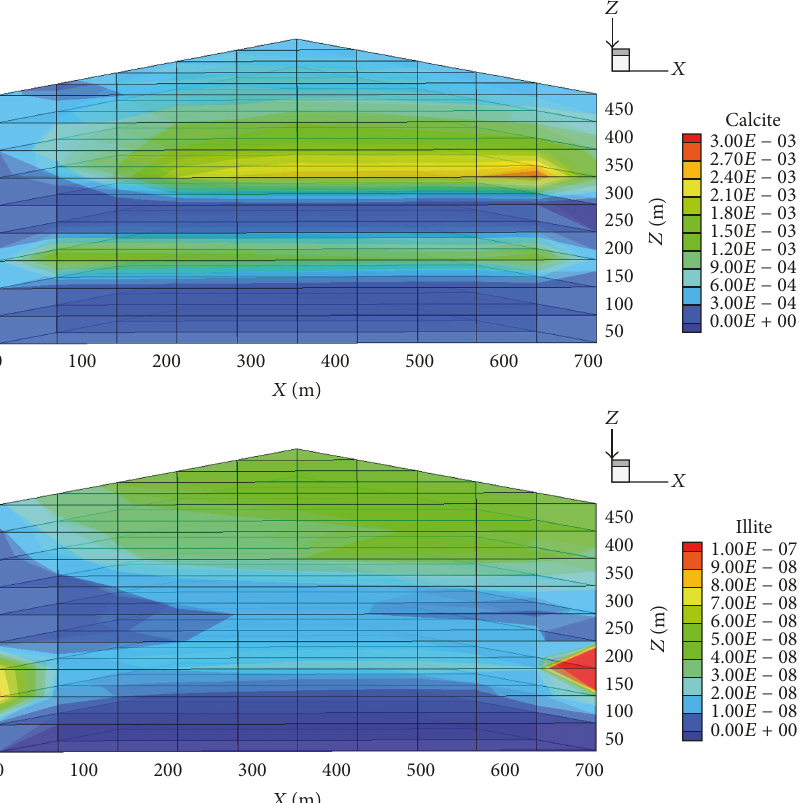
Figure 6: Simulated 3D profiles of changes of mineral abundance (in volume fraction) for secondary minerals (calcite and illite) after 30-year injection of scCO 2 as a working fluid.